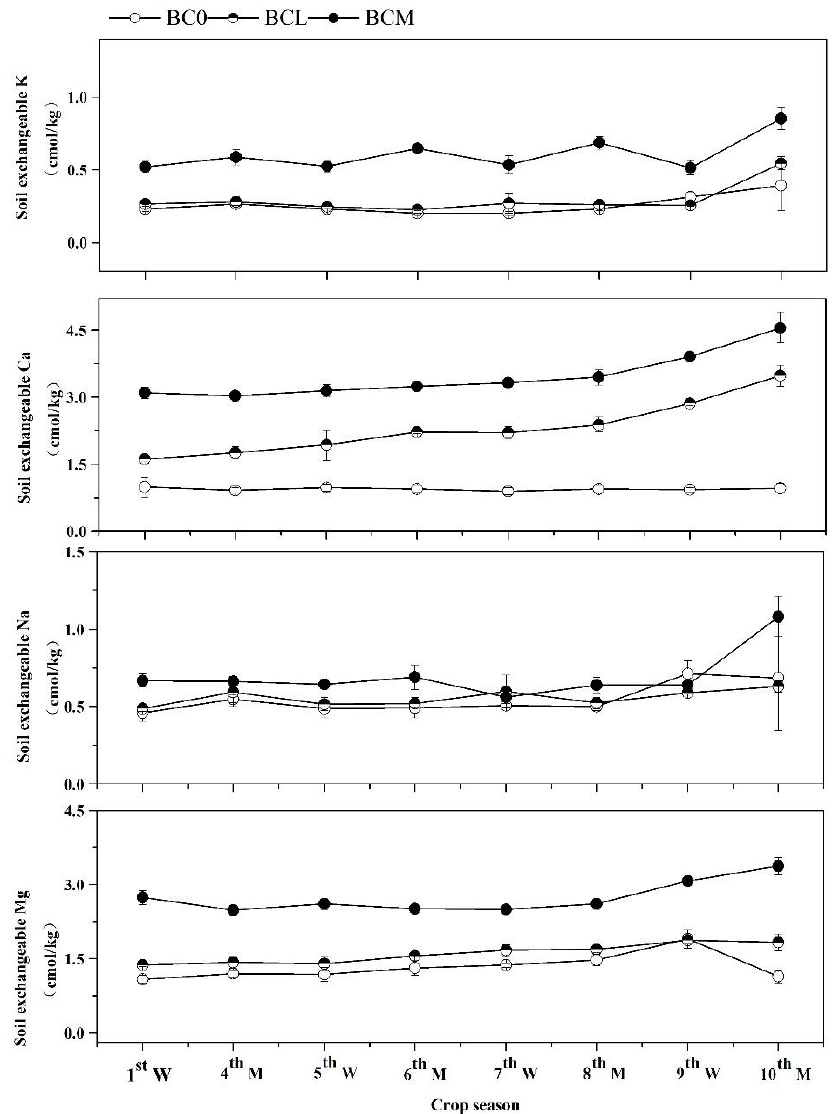
Figure 5. The change of soil exchangeable K + , Ca 2+ , Na + , and Mg 2+ in red soil affected by successive application of straw biochar during 10 consecutive wheat/millet growing seasons from 2010–2015. Soil exchangeable nutrients were not measured in the 2011 millet and 2011–2012 wheat seasons, respectively. Error bars are standard deviations.